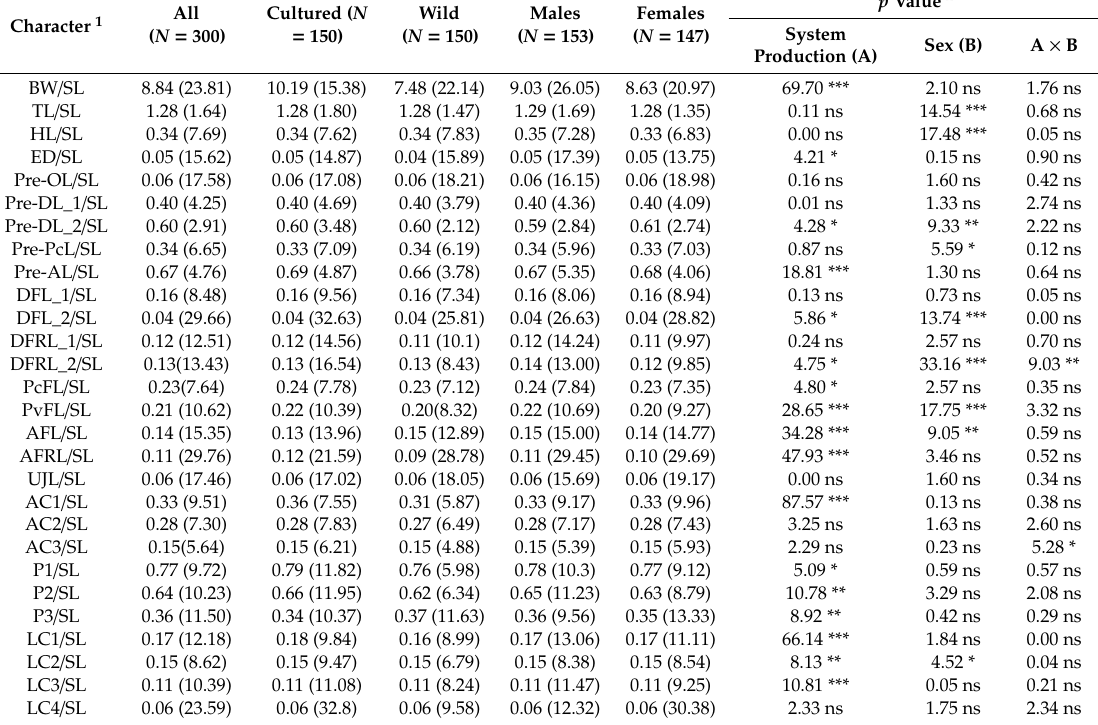
Table 4. Descriptive statistics of the ratio between body measurements and standard length (original data) of Dormitator latifrons from hatchery and wild populations for each sex (mean